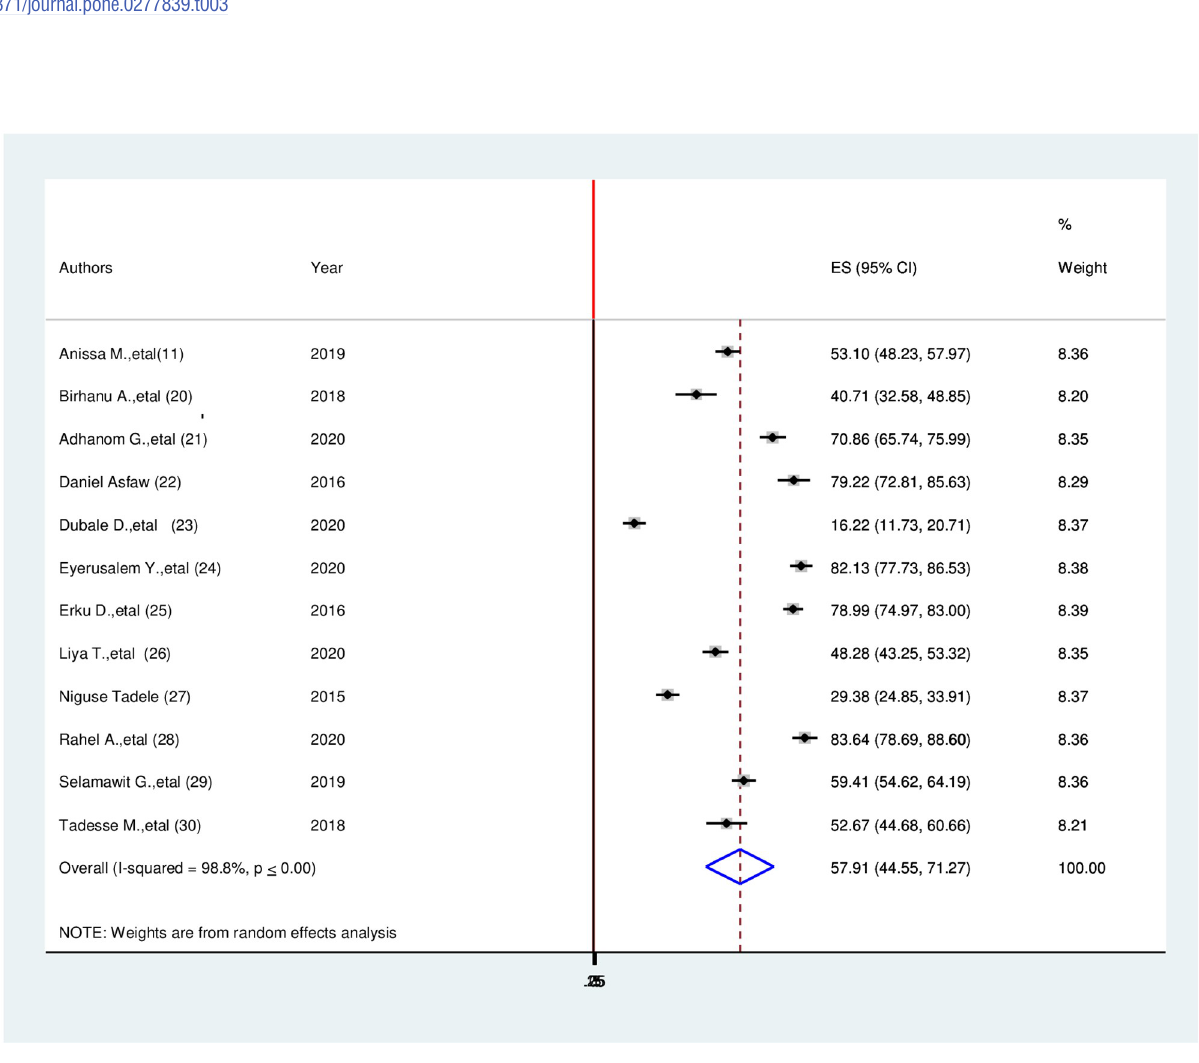
Fig 2. Forest plot for the prevalence of health-related quality of life among cancer patients in Ethiopia,